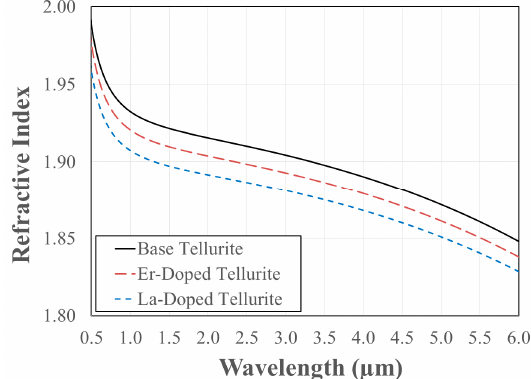
Figure 2. Refractive index curves of bulk tellurite base glass, Er-doped tellurite, and La-doped tellurite measured by ellipsometry.